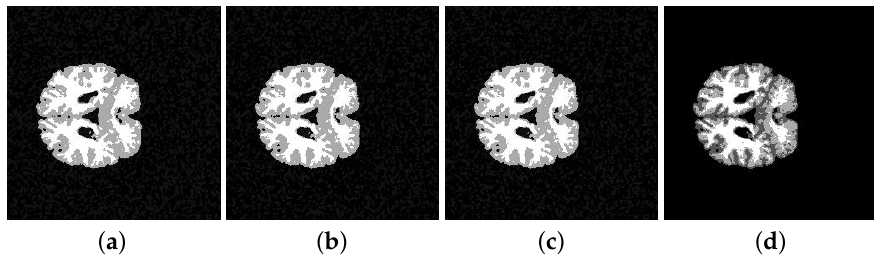
Figure 9. Segmentation of the noised Image 202-3 using K-means ( a ) FCM ( b ) SFCM ( c ) and KFCM ( d ).